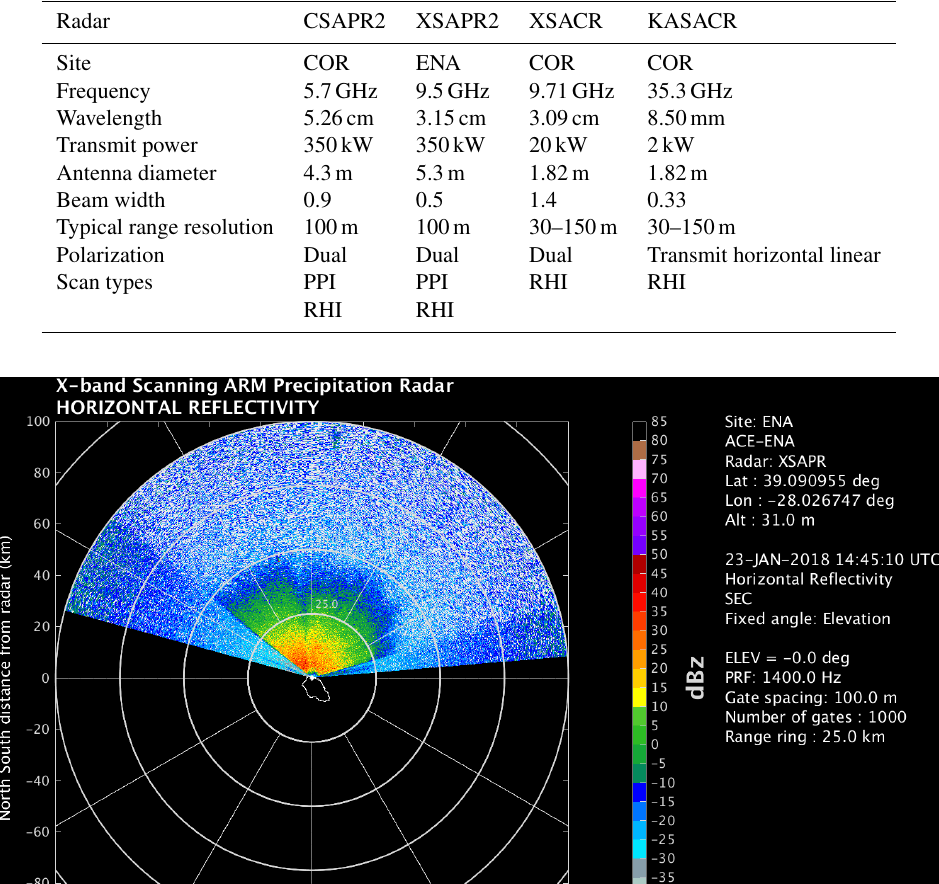
Table 1. Characteristics and specifications for ARM radars used in this study.